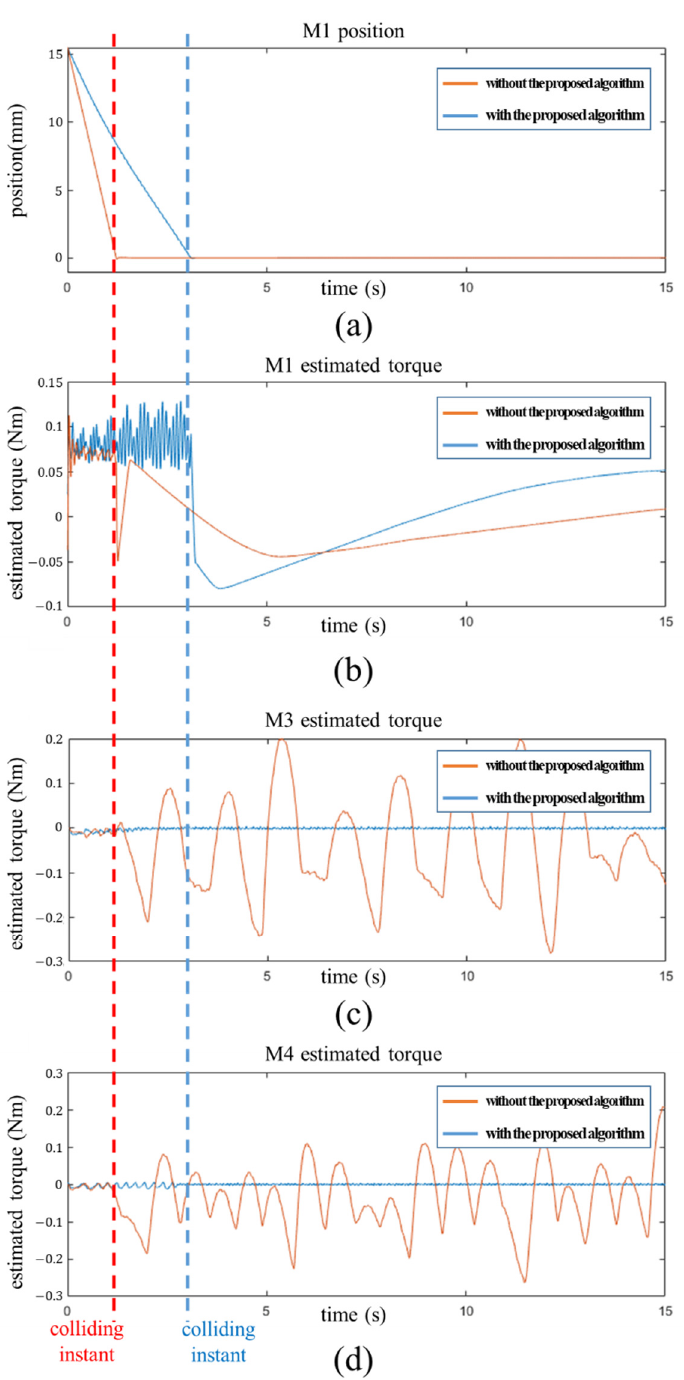
Figure 14. Comparison of experimental results when flying touch and velocity synchronization methods are applied or not applied. ( a ) M1 position; ( b ) M1 estimated torque; ( c ) M3 estimated torque; and ( d ) M4 estimated torque.